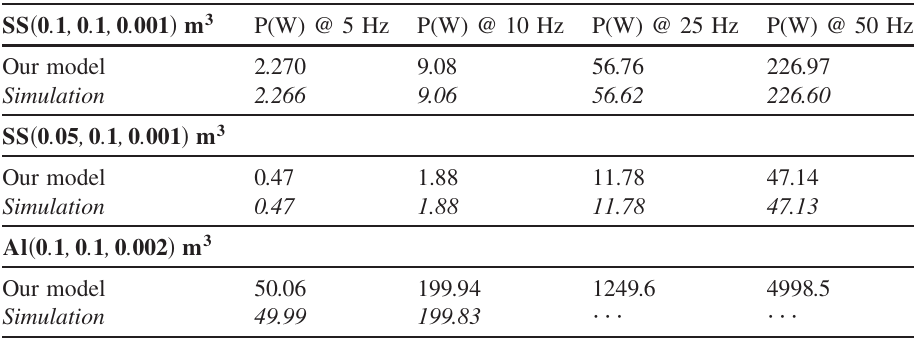
TABLE I. Average power loss at different frequencies for stainless steel (SS) and aluminum (Al) plates of conductivity 1 : 33 (cid:4) 10 6 and 16 : 95 (cid:4) 10 6 s = m , respectively. SS ð 0 : 1 ; 0 : 1 ; 0 : 001 Þ m